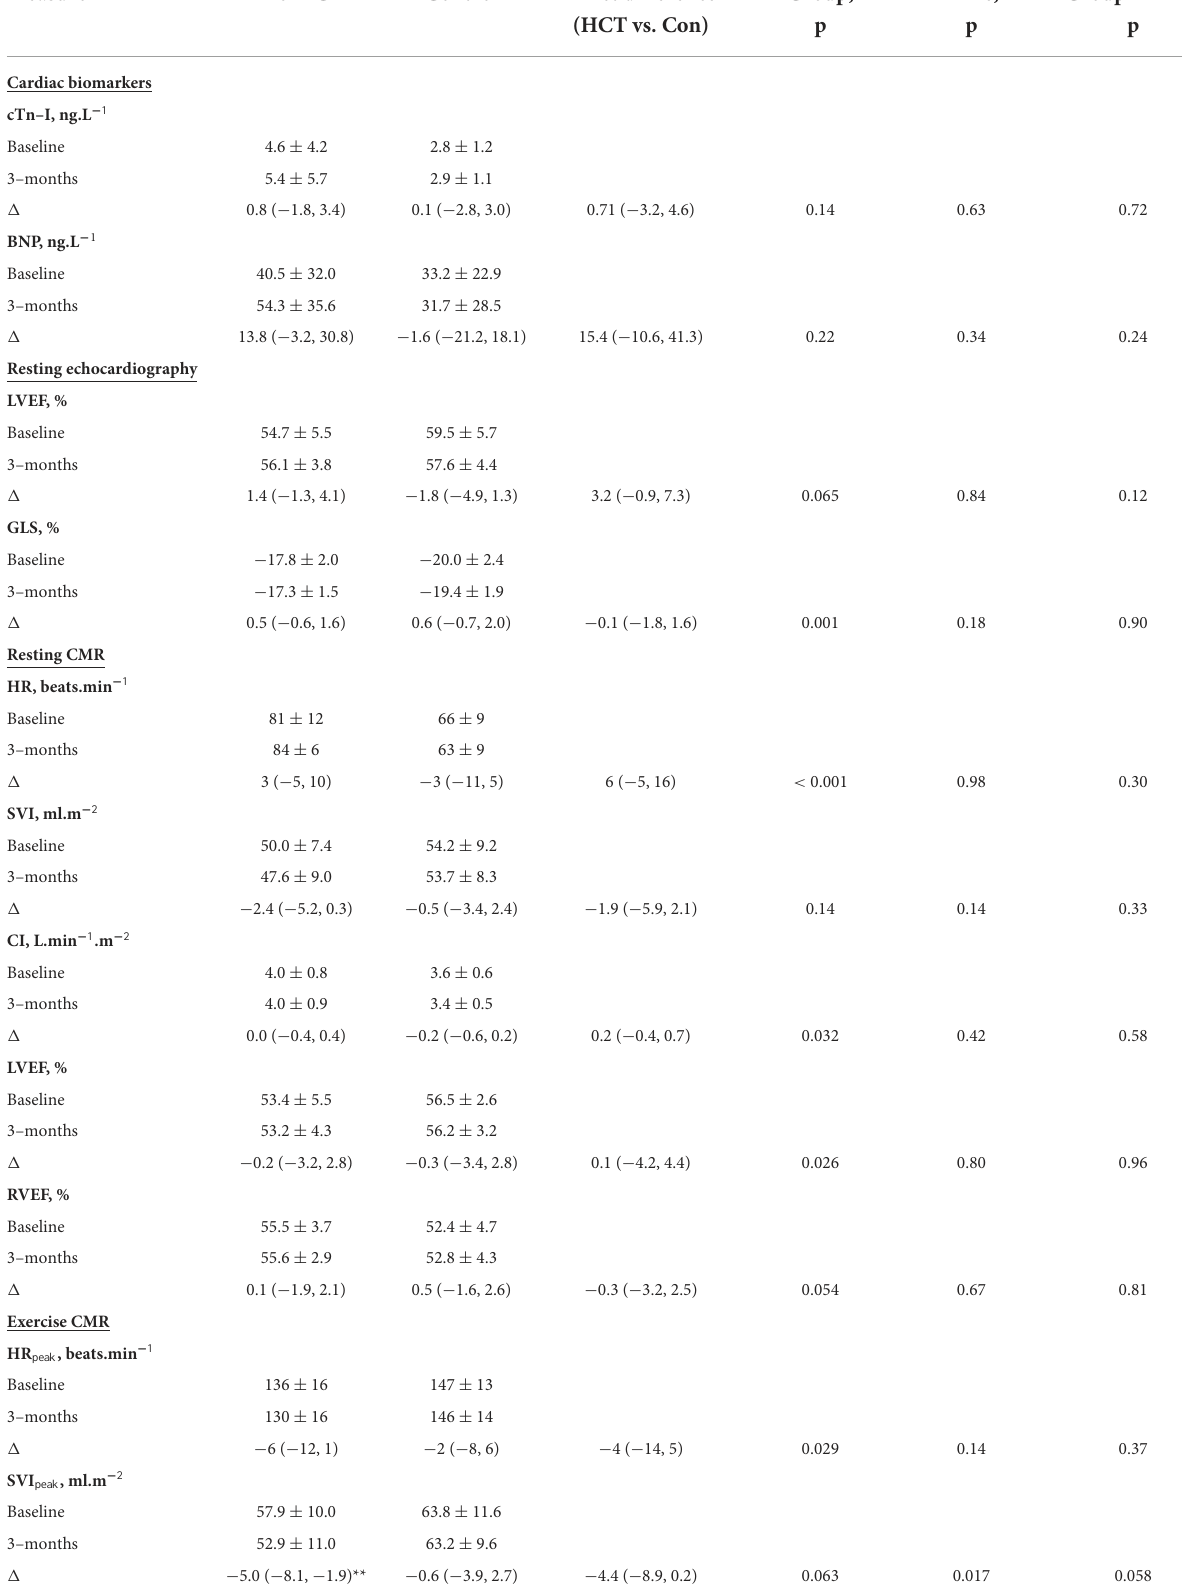
TABLE 4 Mean baseline values, within-group changes after 3–months and the net between-group differences for the change for cardiac parameters in Allo-HCT and Control groups. Measure Allo-HCT Control 1 net difference Group, Time, Group x Time, (HCT vs. Con) p p